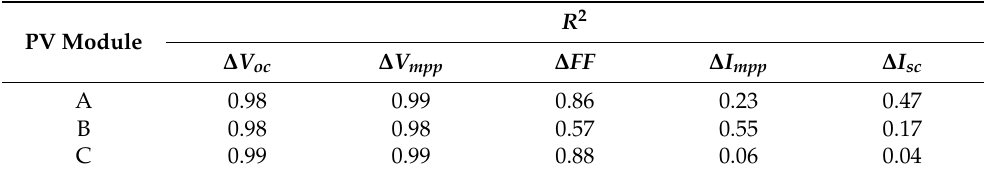
Table 2. Correlation of the degradation in PV modules electrical parameters to the degradation in P max due to PID. R 2 indicates the degree of correlation.